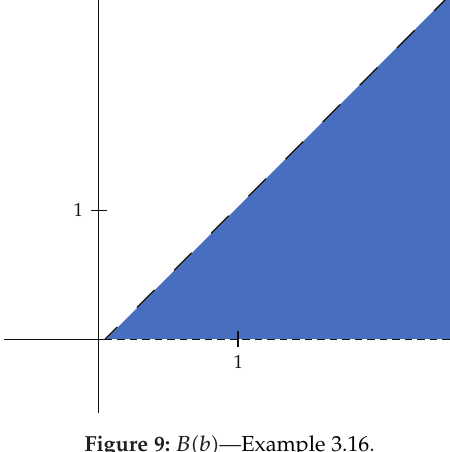
Figure 9: B (cid:2) b (cid:3) —Example